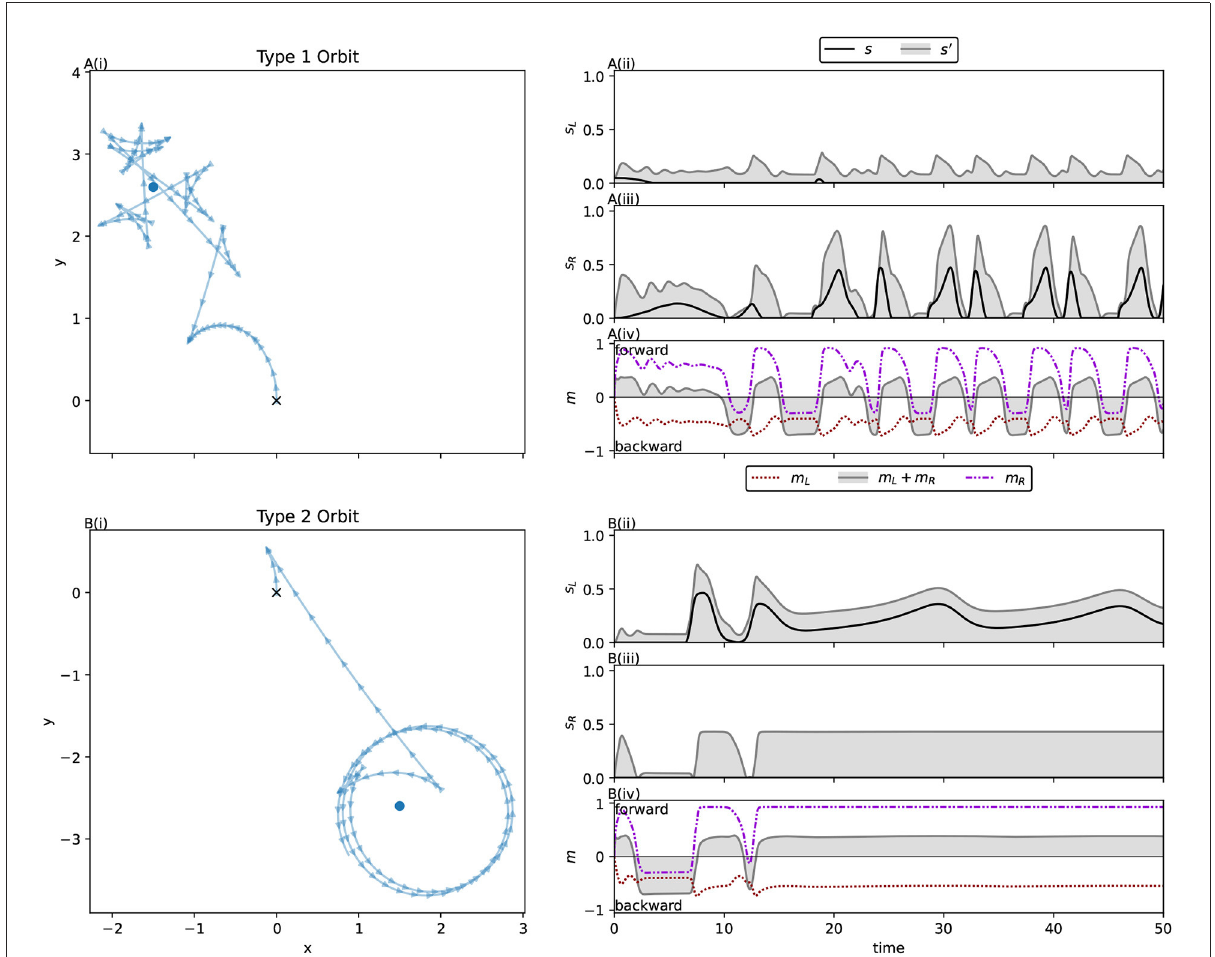
FIGURE10 Spatial trajectories and sensorimotor activity showing a Type 1 and Type 2 orbit for the solution evolved with squared interference. Subfigures are labeled as in Figure 8. (A) Shows a Type 1 orbit reminiscent of the ancestral solution, where motor activity is coordinated with sharp spikes of environmental stimulation of the right sensor. A(iii) Shows how elevated right motor interference coincides with environmental right sensor stimulation, amplifying it. The spiking activity is characteristic of negative feedback in this solution, where action resulting from sensor stimulation leads to the stimulus diminishing. (B) Shows a Type 2 orbit, where the robot orbits while driving forwards. B(iv) Shows how the motor activity plateaus during the orbit, with high right motor interference seen in B(iii) . This is associated with positive feedback in this solution, where sensor stimulation leads to activity prolonging that